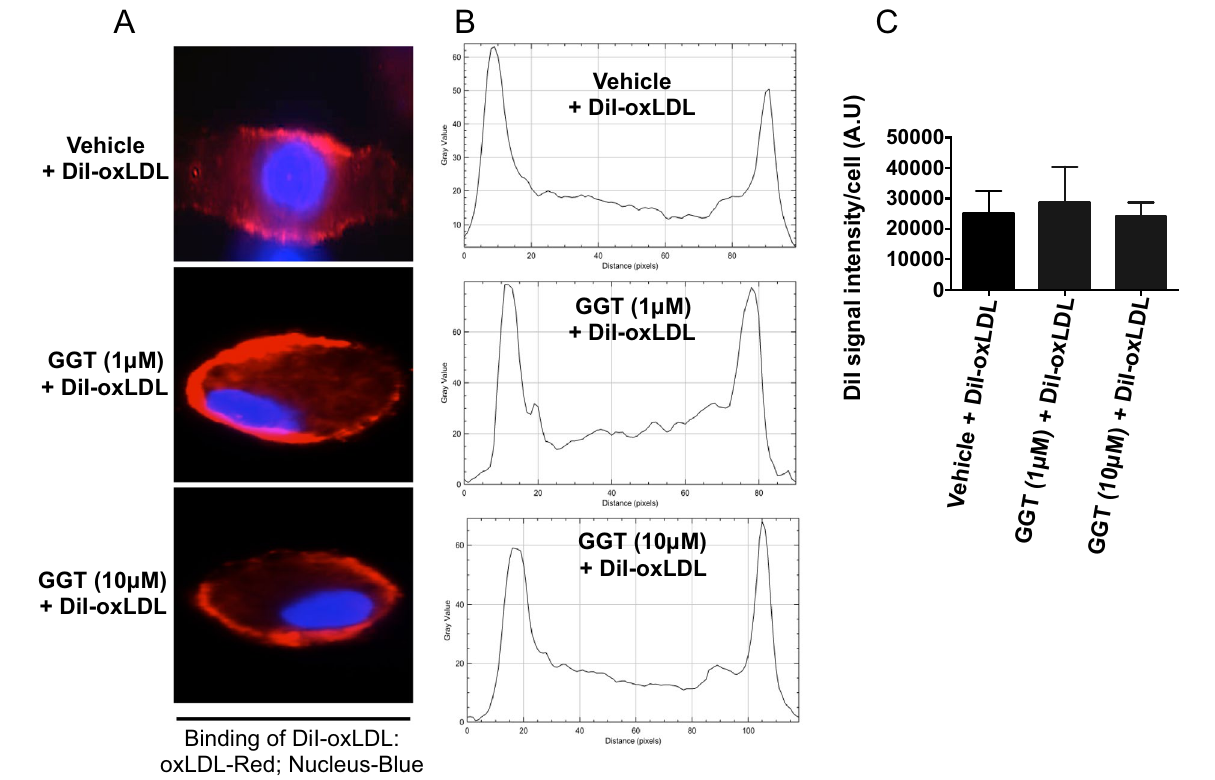
Figure 5. Ginkgetin does not suppress DiI-oxLDL binding to macrophages. Macrophages were pretreated with vehicle or ginkgetin (1 or 10 µM) for 3 h followed by incubation with DiI-labeled oxLDL (2.5 µg/mL) for 1 h at 4 °C. ( A ) Representative fluorescence microscopic images (original magnification, 63×) of DiI-oxLDL binding on macrophage membrane surface (n = 20 cells/condition). ( B ) Results from experiment A shown as plot profile using NIH ImageJ software. ( C ) Quantitative analysis of results from A. n = 20